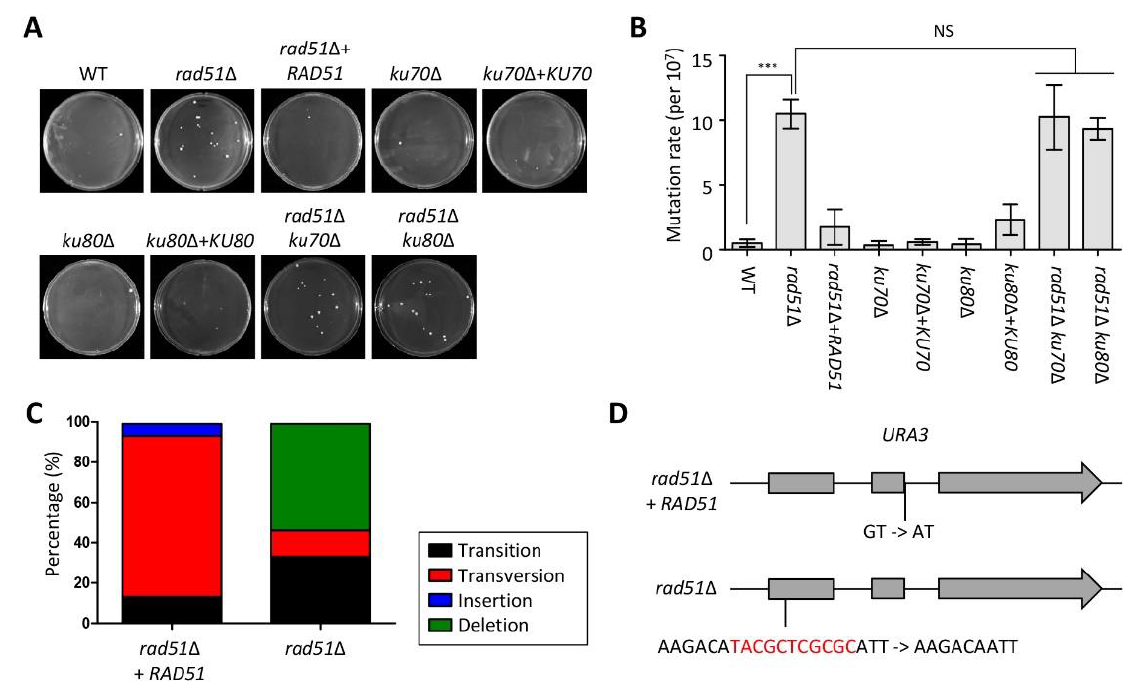
Figure 4. Deletion of RAD51 increases the frequency of mutations. ( A ) Spontaneous 5-FOA-resistant colonies in the wild-type (WT) strain, rad51 ∆ , rad51 ∆ + RAD51 , ku70 ∆ , ku70 ∆ + KU70 , ku80 ∆ , ku80 ∆ + KU80 , rad51 ∆ ku70 ∆ , and rad51 ∆ ku80 ∆ strains. ( B ) Quantification of spontaneous 5-FOA-resistant rates in the homologous recombination HR and NHEJ mutants. Three independent experiments with five samples were performed. Statistical significance of difference was determined by one-way analysis of variance (ANOVA) with Bonferroni’s test. Error bars indicate standard errors of means (*** p < 0.001). ( C ) Mutation profiling of 5-FOA-resistant strains isolated from rad51 ∆ + RAD51 and rad51 ∆ mutants. ( D ) Schematic representation of URA3 mutation in 5-FOA-resistant strains isolated from rad51 ∆ + RAD51 and rad51 ∆ mutants. Nucleotides marked with red were deleted in the URA3 gene in 5-FOA-resistant strain isolated from the rad51 ∆ mutant. Next, to determine whether HR and NHEJ are involved in the acquisition of drug- resistance-like fluctuations, we calculated the colony frequency of fluconazole-resistant strains. In contrast to the results of the fluctuation analysis, deletions of HR and NHEJ genes did not change the frequency of fluconazole resistance (Figure S3). These data indi- cate that HR and NHEJ are insufficient for increasing the frequency of fluconazole re- sistance. Previous studies have reported that disruption of the mismatch repair pathway and the lack of DNA polymerase, POL3 , lead to rapid microevolution [37,38]. Furthermore, the result that perturbation of RAD51 increased mutation rate in the fluctuation assay led us to investigate whether HR and NHEJ are involved in microevolution. To determine the roles of HR and NHEJ components in microevolution, we compared phenotypic changes in the original WT, rad51 Δ , ku70 Δ , ku80 Δ , rad51 Δ ku70 Δ , and rad51 Δ ku80 Δ mutants to those of the corresponding three independent passage strains depending on the number of generations (around 300, 600, and 1000 generations) in response to diverse stress re- sponses, including oxidative stress, DNA damage stress, and antifungal drug resistance. In approximately 300 generations, passaged strains from rad51 Δ , rad51 Δ ku70 Δ , and rad51 Δ ku80 Δ mutants exhibited different degrees of stress resistance in response to bleo- mycin and HU compared to the original strain (Figure S4A). However, the passaged strains (about 300 generations) from WT, ku70 Δ , and ku80 Δ mutants showed similar phe- notypes as those of the original strain (Figure S4A). In approximately 600 generations, passaged strains from ku70 Δ and ku80 Δ mutants also showed phenotypic changes under bleomycin, HU, hydrogen peroxide, fluconazole, and amphotericin B treatment (Figure